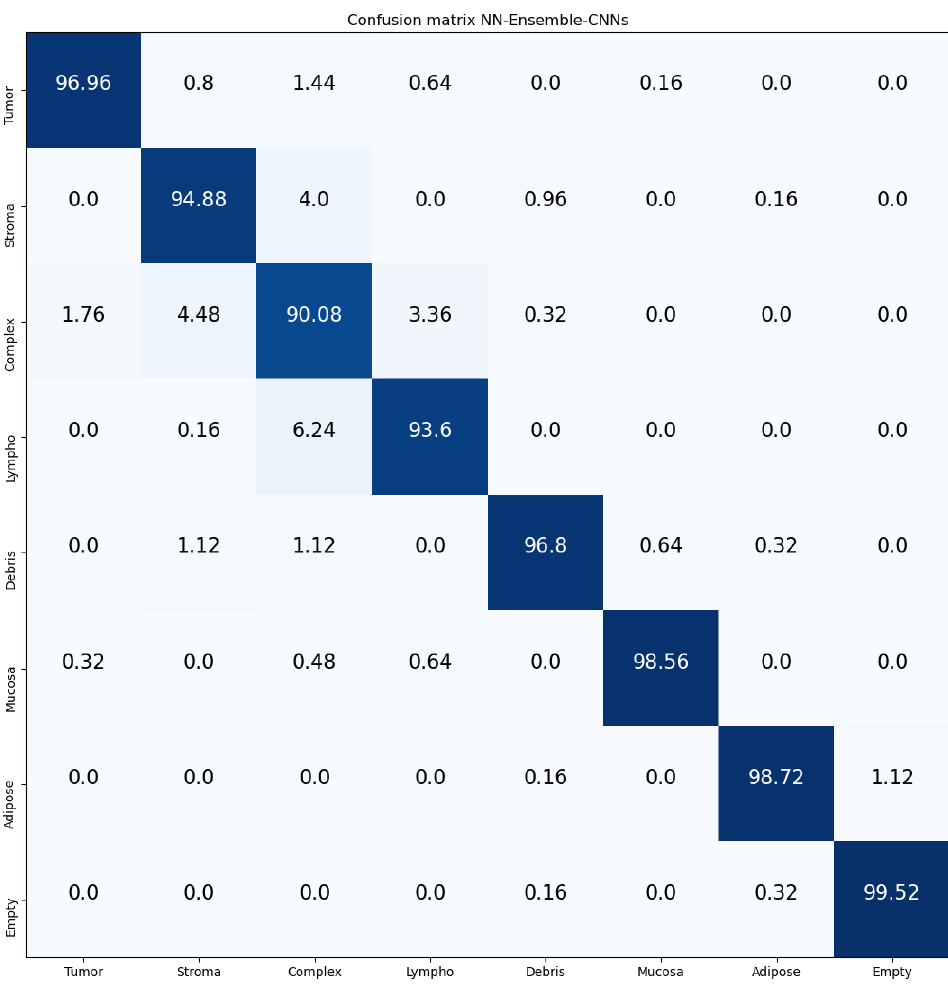
Figure 15. Confusion Matrix of our proposed approach: NN-Ensemble-CNNs on Kather-CRC-2016 database. The vertical axis is for the true classes and the horizontal axis is for the predicted